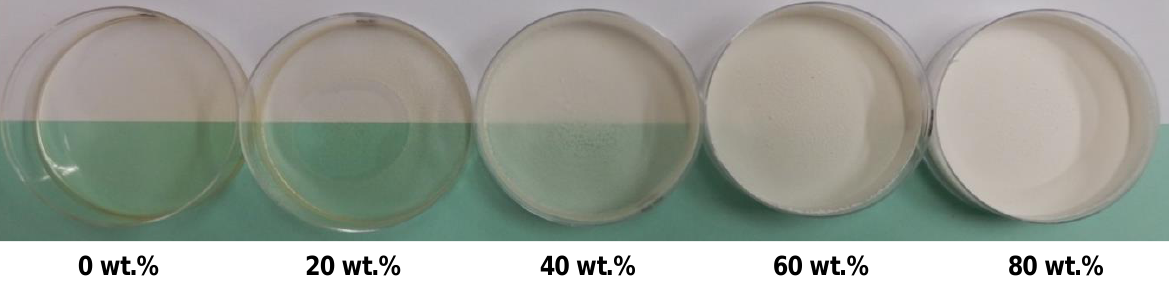
Figure 5. Visual aspect of chitosan films prepared with different amounts (wt.%) of modified PCC. Chitosan was first solubilized (1.0% w / v ) in lactic acid solution (0.5 vol.%) before incorporation of modified PCC.